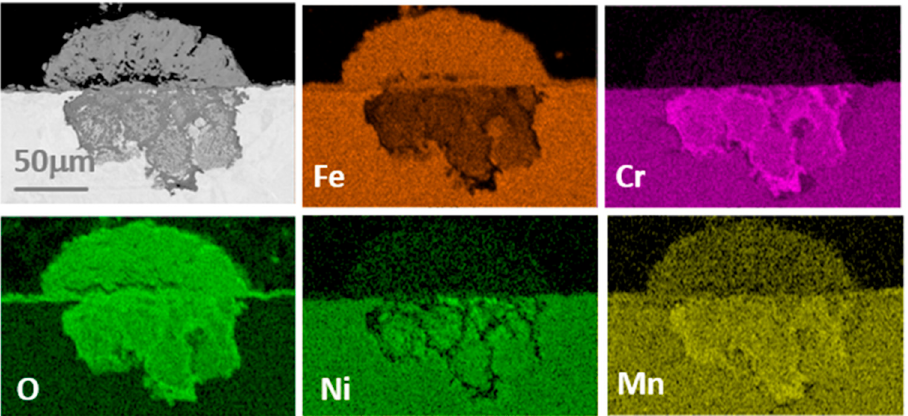
Figure 9. FESEM cross section and EDS element maps of HT347HFG exposed to steam at 700 °C under atmospheric pressure after 3000 h. atmospheric pressure after 3000